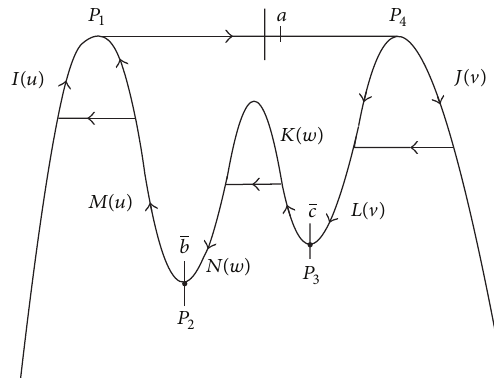
Figure 4: Canard cycle having two jump points and two turning